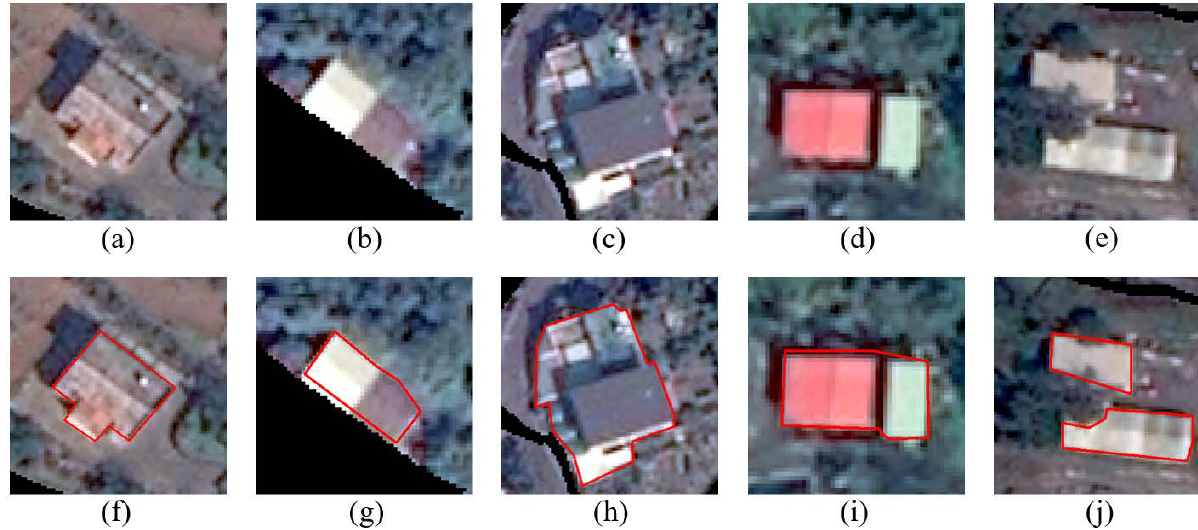
Figure 3 . Examples of manual digitization results from different building patterns. (a) A building with shadow; (b) A building cut by non-agricultural mask; (c) Adjacent buildings; (d)Buildings in close proximity; (e) Buildings occluded by vegetation; (f)(g)(h)(i)(j) Manual digitization results of above building